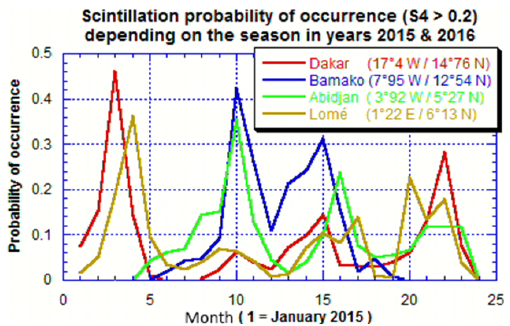
Figure 3. Scintillation probability of occurrence at low latitudes de- pending on the season.